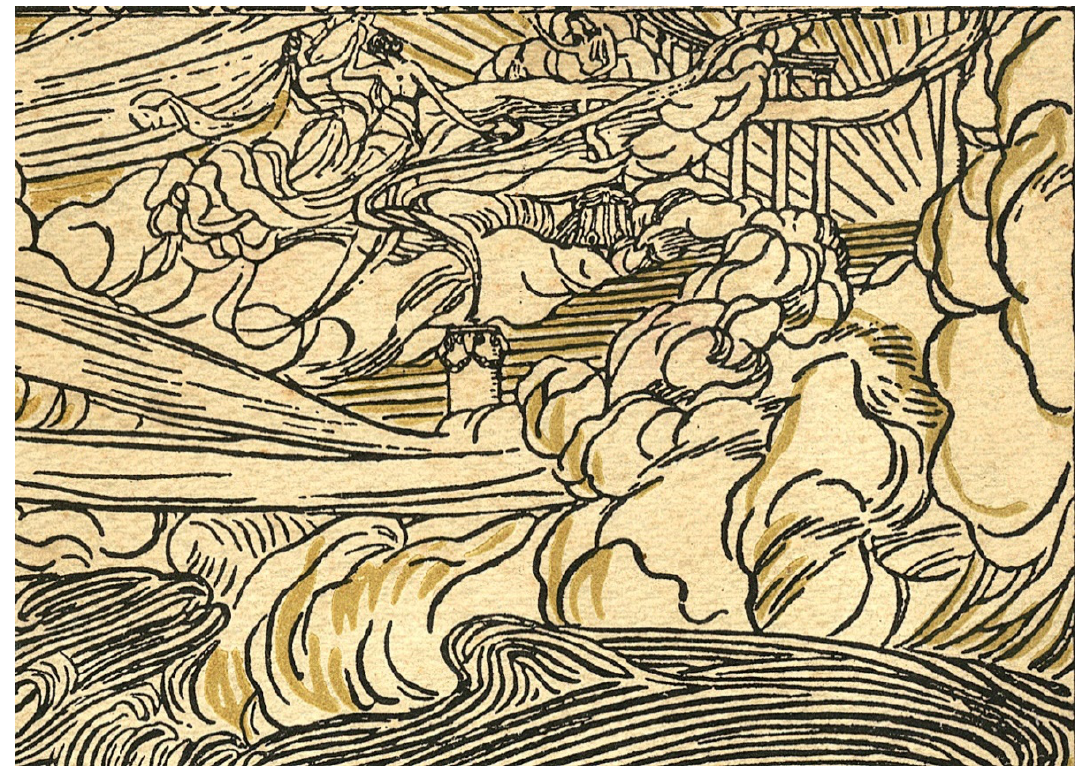
Figure 18. Journal Dreamers’ Notes (1919–1922). Cover by Aleksandr Golovin. Fragment.